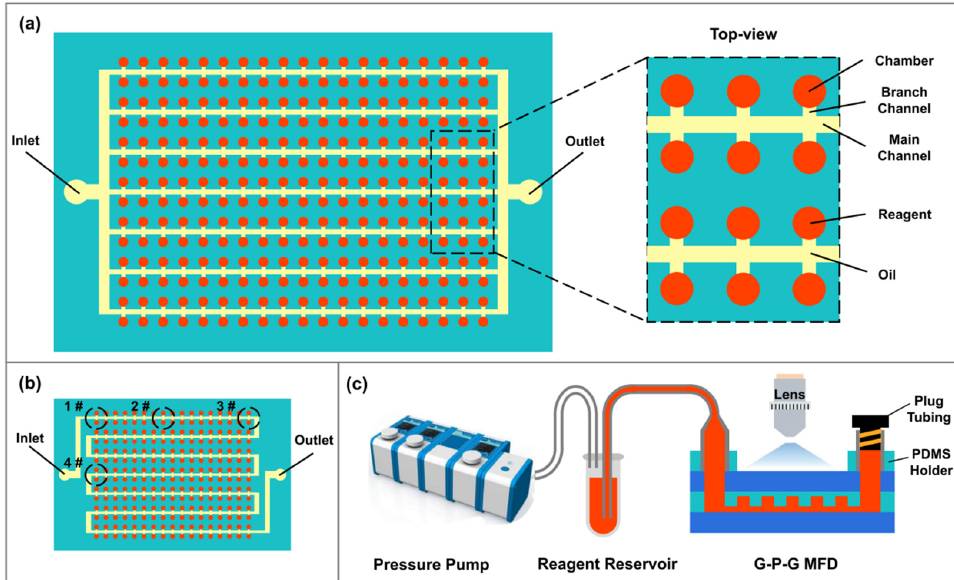
Figure 2. Schematic of the G-P-G MFD design with different main channel shapes: ( a ) parallel-shaped and ( b ) S-shaped, which is with different distances from I/O ports, the distance increase from 1# to 4#. ( c ) Schematic of the G-P-G MFD leakage test experiment platform setup. In the schematic, the red color is the reagent, and the yellow one is oil. The Aquamarine color is PDMS chip, and the blue one is glass cover.